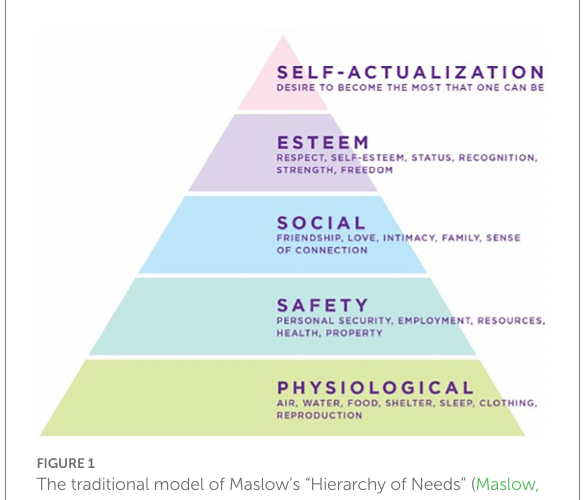
FIGURE 1 The traditional model of Maslow’s “Hierarchy of Needs” (Maslow, 1943).